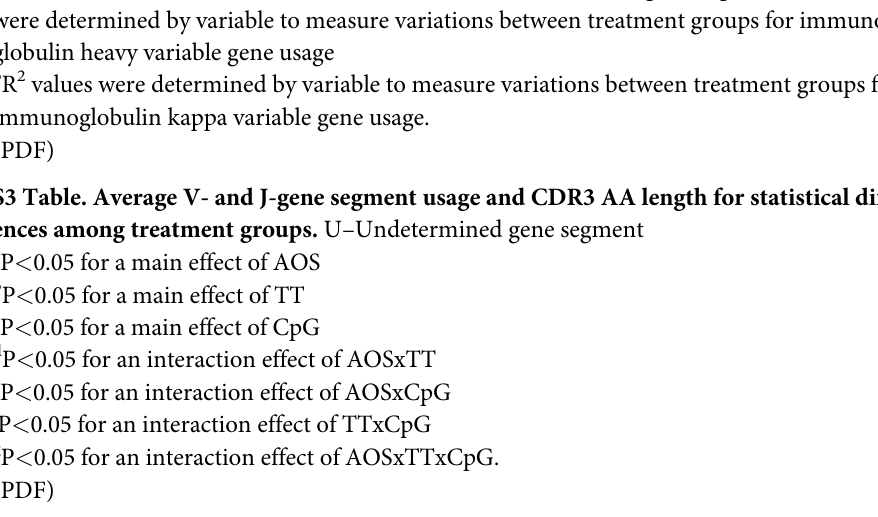
S4 Table. R 2 of V/J pairing correlation by variable. a R 2 values were determined by variable to measure variations between treatment groups for immunoglobulin heavy variable gene usage b R 2 values were determined by variable to measure variations between treatment groups for immunoglobulin kappa variable gene usage. S5 Table. Average V/J pairings for heavy chain for statically different pairings. U–Undeter-